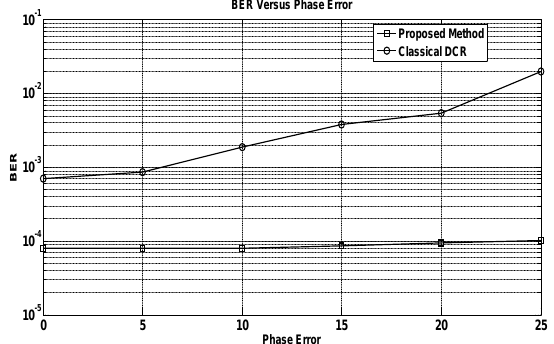
Figure 3: BER versus Phase Error (degree)